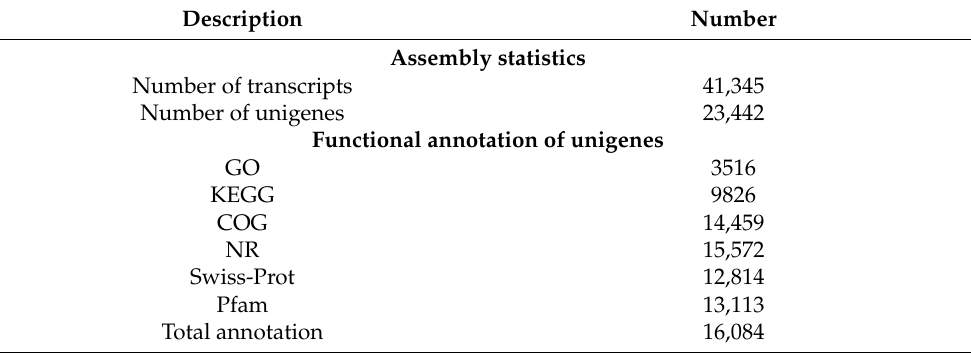
Table 3. Summary of assembly statistics and functional annotation of